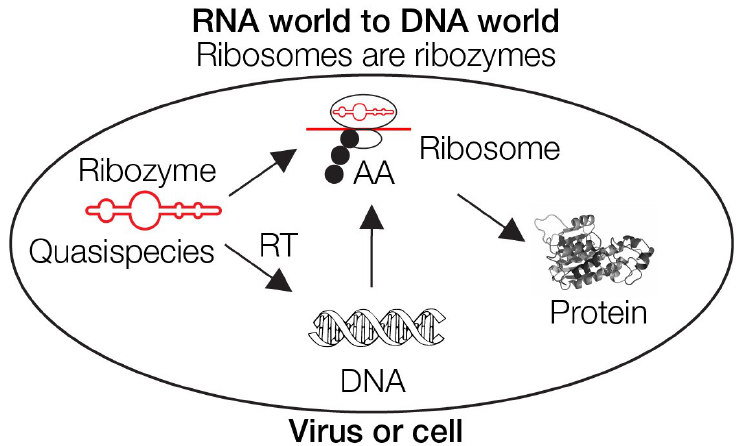
Figure 2. Reactions that may have taken place in a pre-cell. From a quasispecies of RNA, ribozymes may have formed. Some of the ribozymes might have been capable of forming peptide bonds or generate a DNA copy of themselves. The reverse transcriptase (RT) accelerated DNA formation.